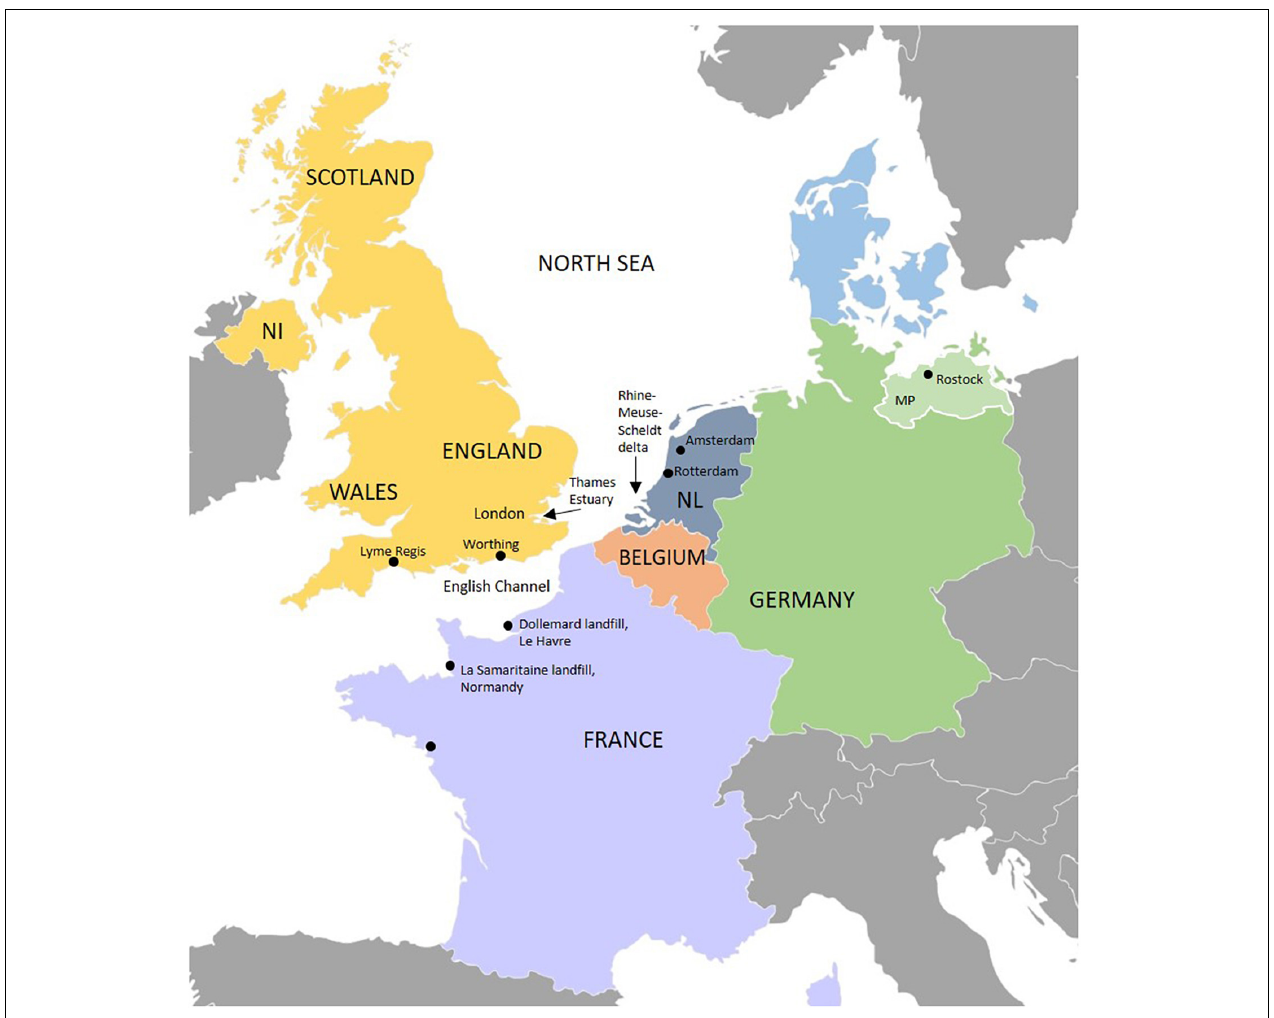
FIGURE 1 | Locations of the case studies in Europe. NI, Northern Ireland; NL, Netherlands; MP, Mecklenburg-West